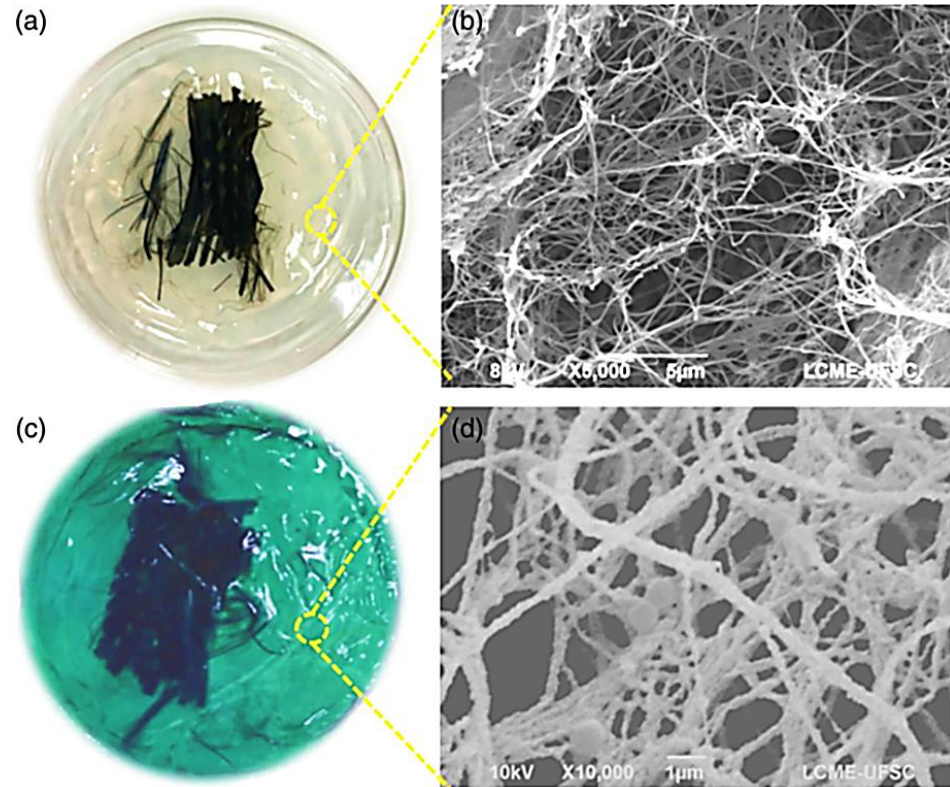
Figure 2. Morphological evaluation of bacterial cellulose sample and bacterial cellulose/polyaniline nanocomposite. ( a ) Carbon fiber embeds into bacterial cellulose hydrogel; ( b ) scanning electron mi- croscopy micrograph of an interconnected network of bacterial cellulose nanofibers; ( c ) carbon fiber embeds into cellulose/polyaniline nanocomposite; and ( d ) scanning electron microscopy image of cellulose/polyaniline nanocomposite [68]. Reproduced with permission from Wiley.